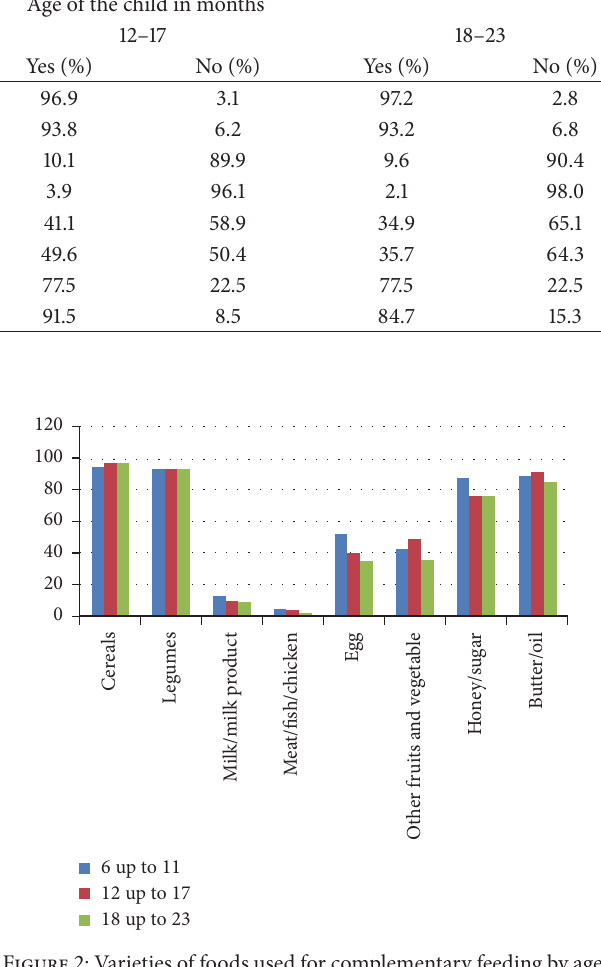
Figure 2: Varieties of foods used for complementary feeding by age groups, Lasta District, Amhara region, Ethiopia,